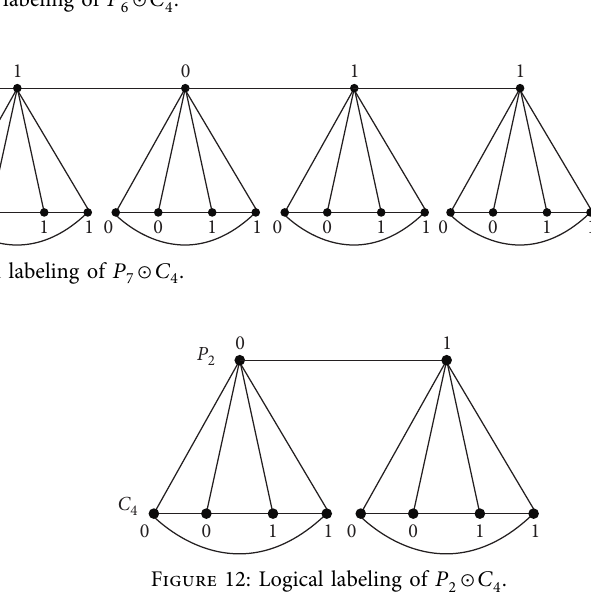
Figure 9: Logical labeling of P